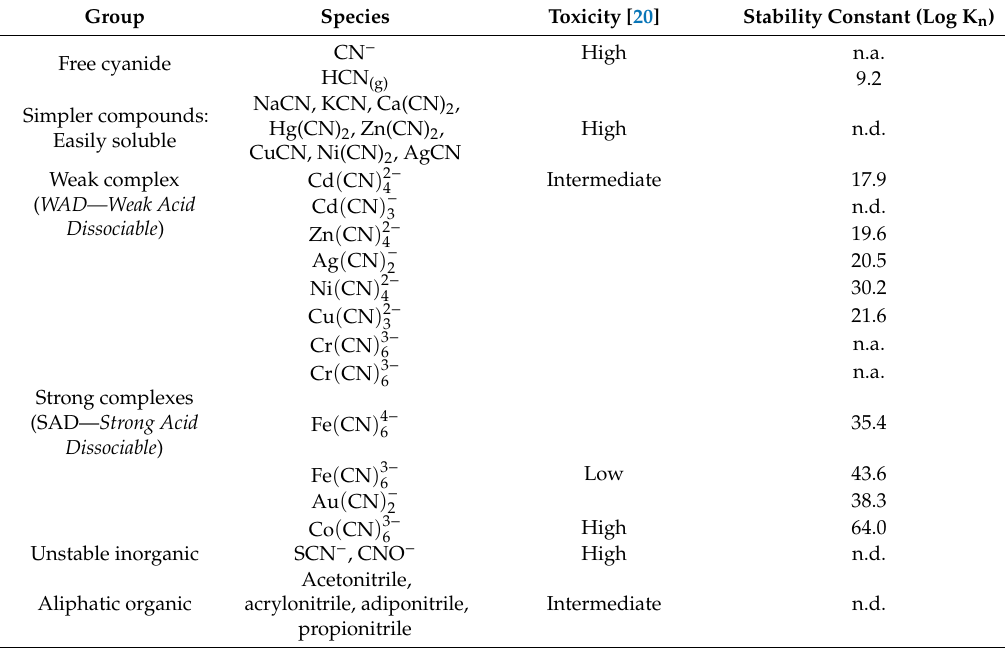
Table 1. Stability of cyano-metallic complexes